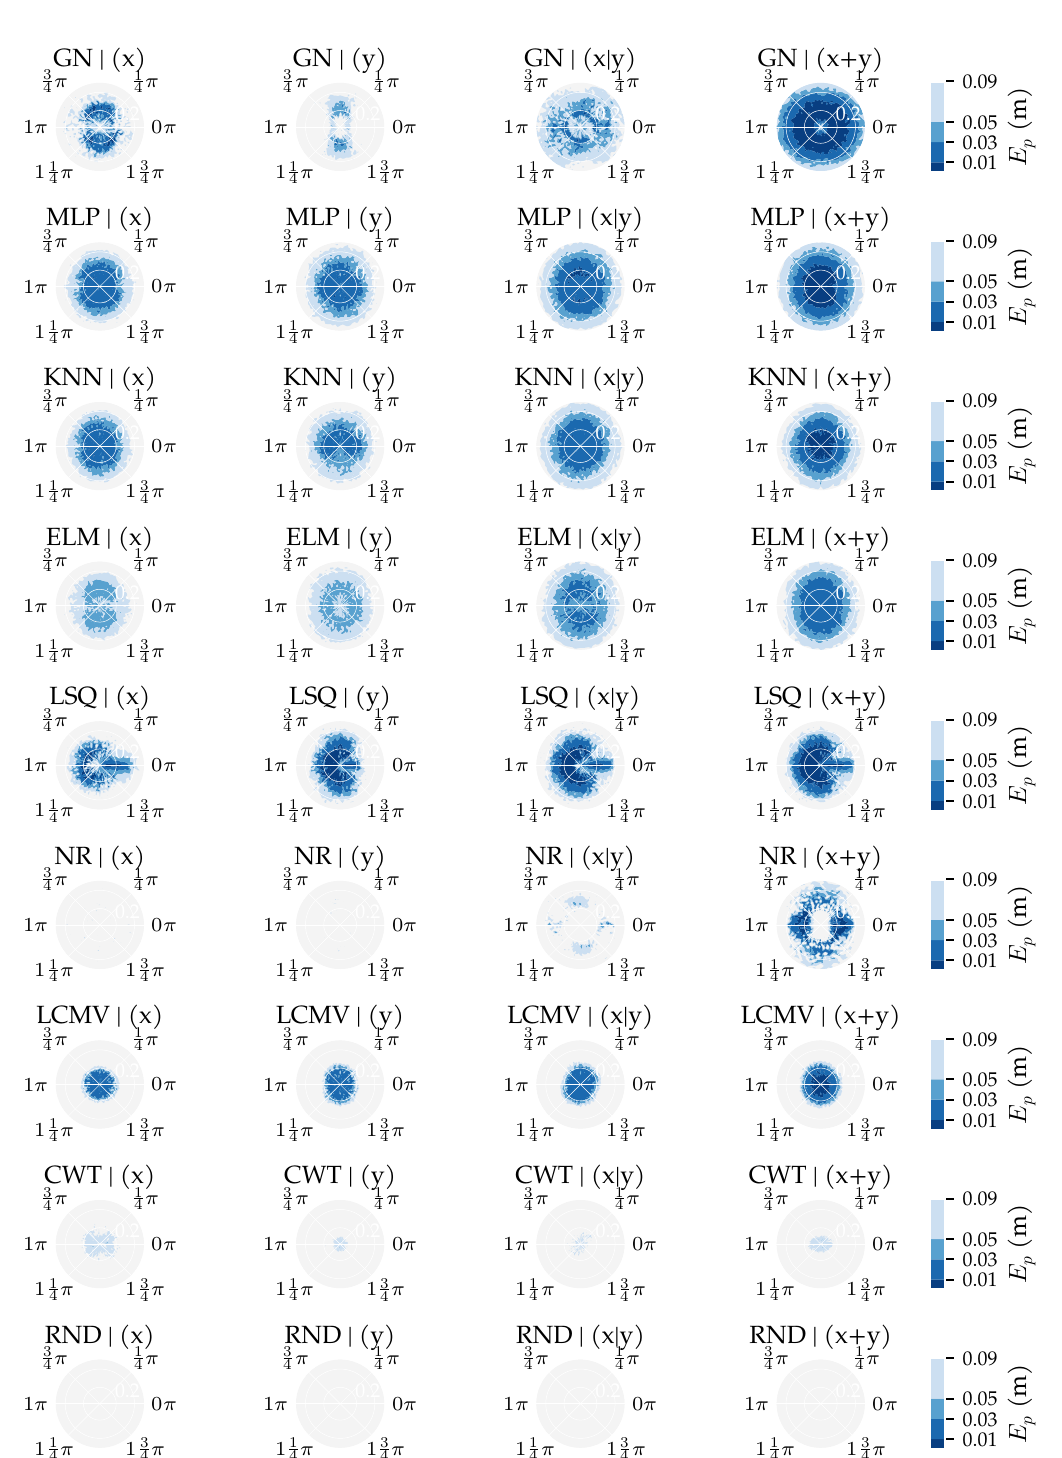
Figure A10. Polar contours of the median position error (Equation (4)) for each localisation algorithm in all conditions of Analysis Method 2. These figures indicate how the movement direction ϕ and distance d of a source influence the error. This analysis varied the sensitivity axes of the sensors: (x + y) measured both velocity components at all sensors, (x|y) alternated measuring v x and v y for subsequent sensors, (x) measured only v x at all sensors, (y) measured only v y at all sensors. The D s = 0.01 training and optimisation set and σ = 1.0 × 10 − 5 ms − 1 noise level were used. The median position error was computed in 2 × 2 cm 2 cells. The sensors were equidistantly placed between x = ± 0.2